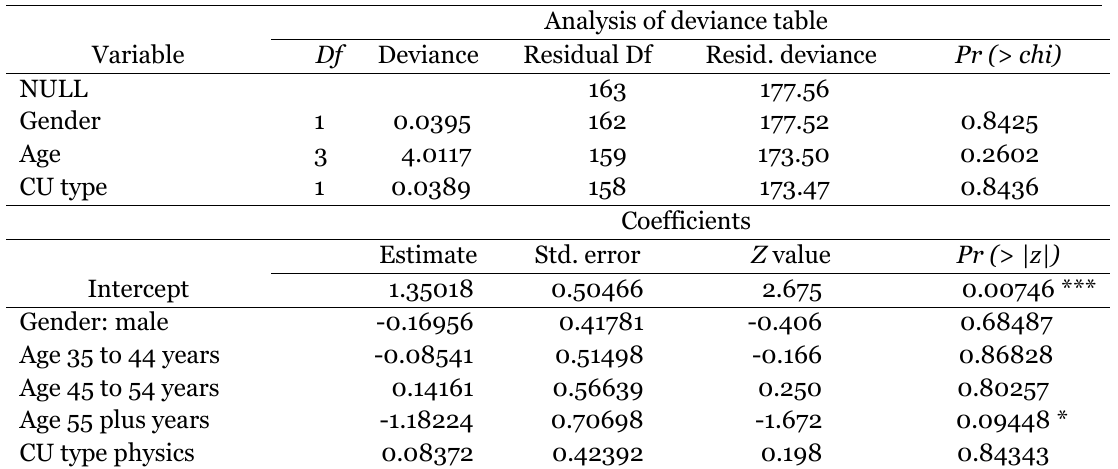
Table 2 Significance of the Use of Mobile Devices in Course Study